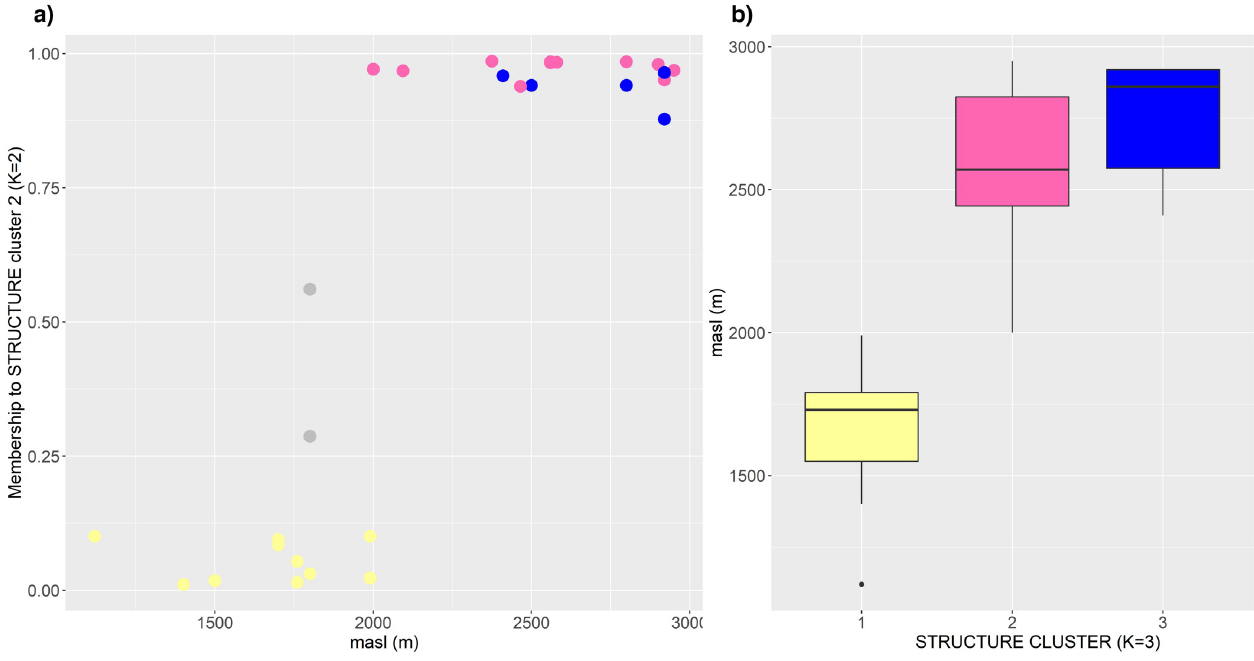
Fig 4. Relationship between population structure and altitude of the collection site. (a) Scatterplot of altitude vs. the inferred ancestry to STRUCTURE cluster 2 (K = 2). (b) Box plots of altitude of collection site for the groups inferred with K = 3.